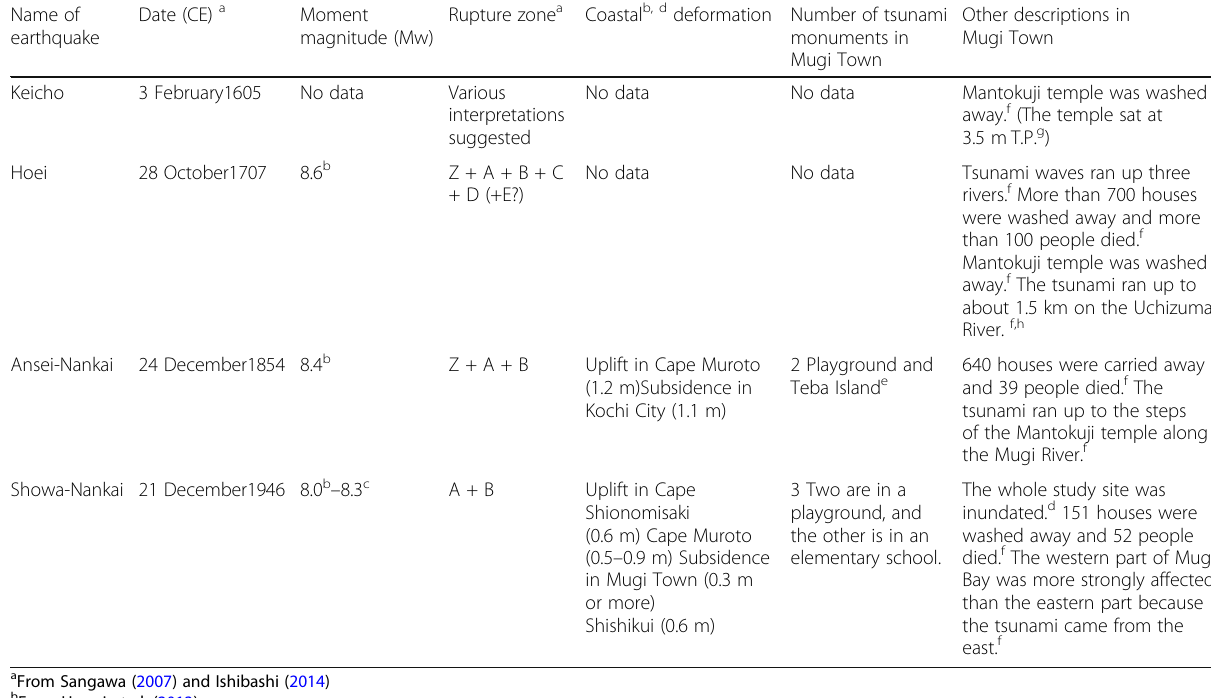
Table 1 Information of the last four historical earthquakes and tsunamis Name of